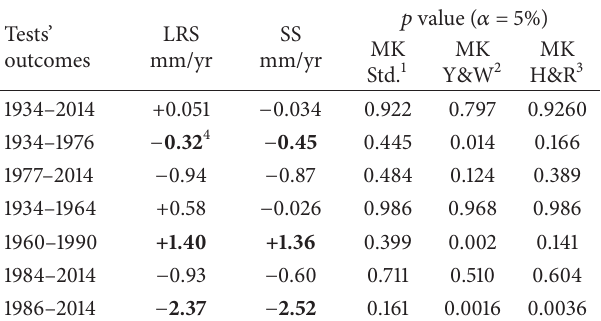
Table 3: Mean annual rainfall trend: MK statistics (one-tailed with 5% significance interval) for the different aggregated periods with and without